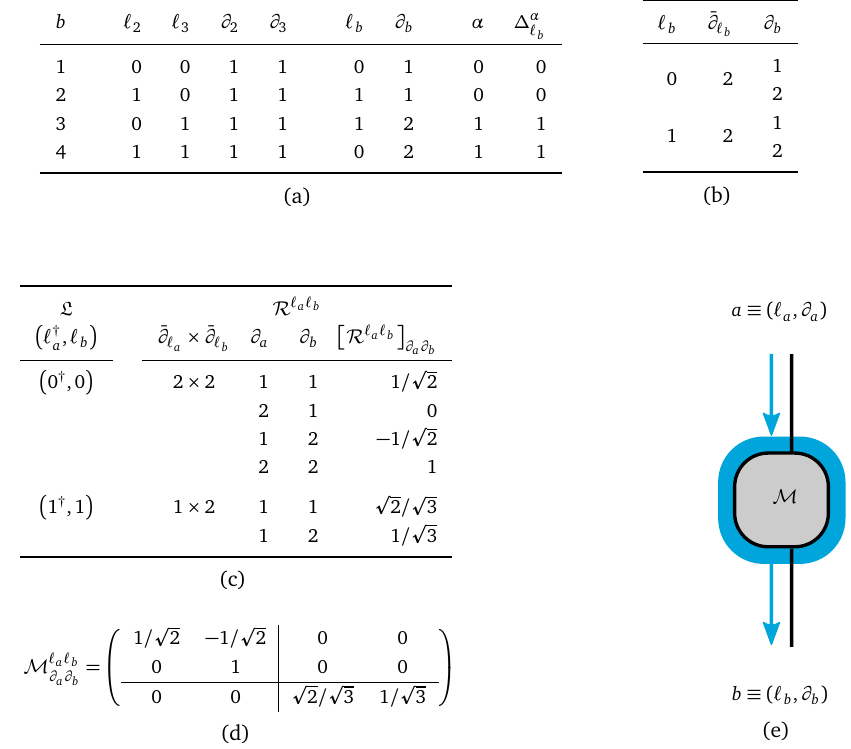
) = fuse (( (cid:96) ) , ( (cid:96) )) of the last two , ∂ , ∂ , ∂ b b 2 2 3 3 ( (cid:96) (cid:96) ) (cid:96) 1 2 3 from the example in Fig. 15: In (a), we show the fuse ( ∂ ∂ ) ∂ 1 2 3 , (cid:96) , ∂ , ∂ . 2 3 2 3 help us in the (cid:96) b , (cid:96) that fuse to the 2 3 + 1,..., ∆ α + 1 = ¯ ∂ up to ∆ 2 of the (cid:96) (cid:96) (cid:96) (cid:96) b b b b